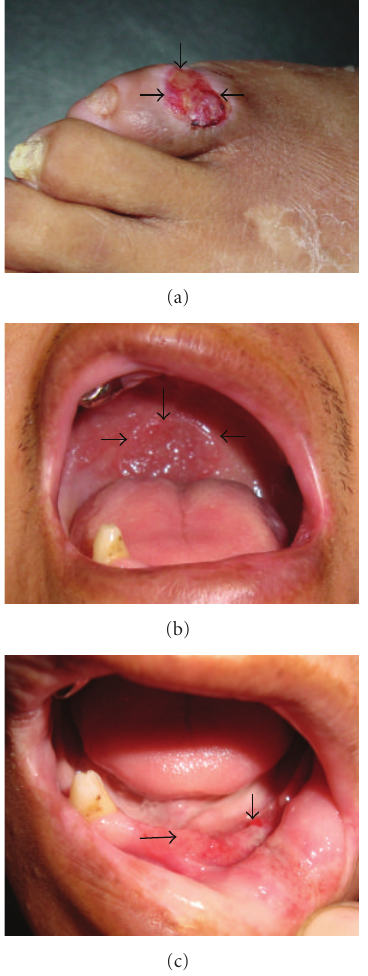
Figure 1: Clinical picture with arrows showing (a) chronic foot ulcer, (b) clear palate ulcer, and (c) mouth ulcer.